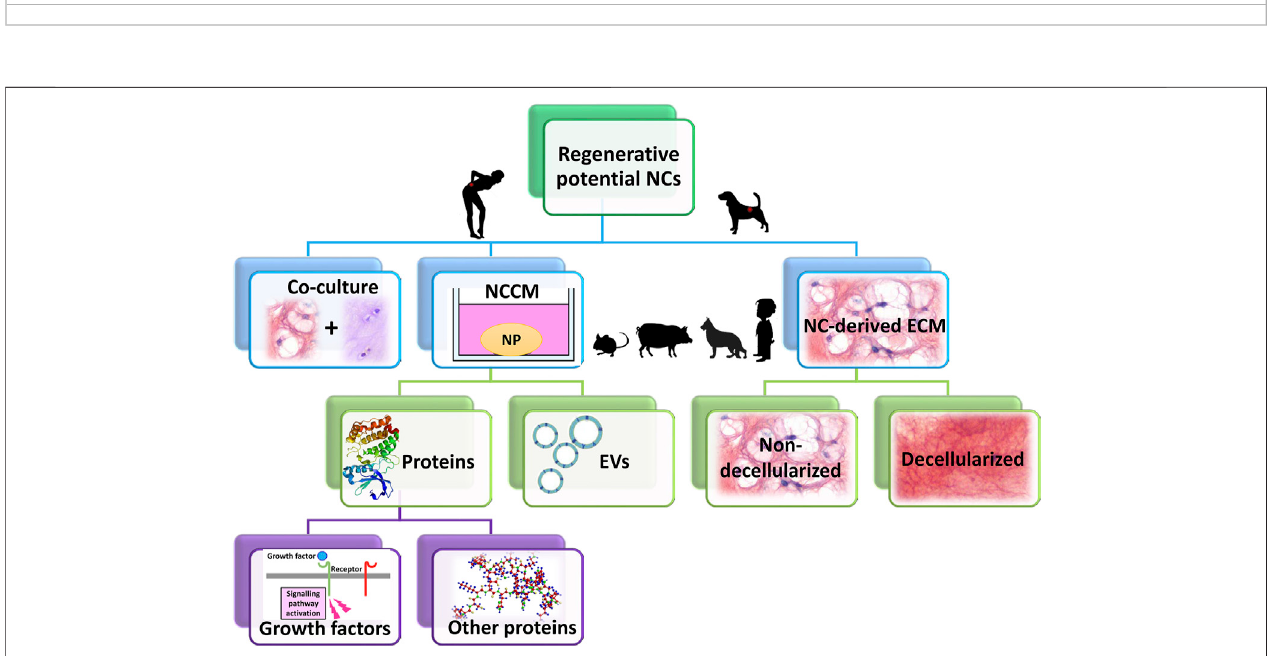
FIGURE 5 | The therapeutic potential of notochordal cells (NCs) has been studied in several ways: either in co-culture with (degenerated) nucleus pulposus cells (NPCs) or by NC-conditioned medium (NCCM). NCCM contains all (bioactive) factors that NCs have secreted, and has been shown to exert regenerative effects on for instance canine and human NPCs (species that suffer from clinical IVD disease). In NCCM, several proteins (growth factors) have been identi fi ed, besides extracellular vesicles (EVs). The recent focus of several research groups has shifted from NCCM towards NC-derived extracellular matrix (ECM). This NC-derived ECM (both non-decellularized and decellularized) has been shown to exert regenerative effects, even in in vivo canine and rabbit studies. Species that are most commonly used to generate NCCM or NC-derived ECM are small rodents (mice, rats), rabbits, pigs, non-chondrodystrophic dogs. In limited studies, human NC-rich tissues have been employed derived from fetal IVD or from diseased